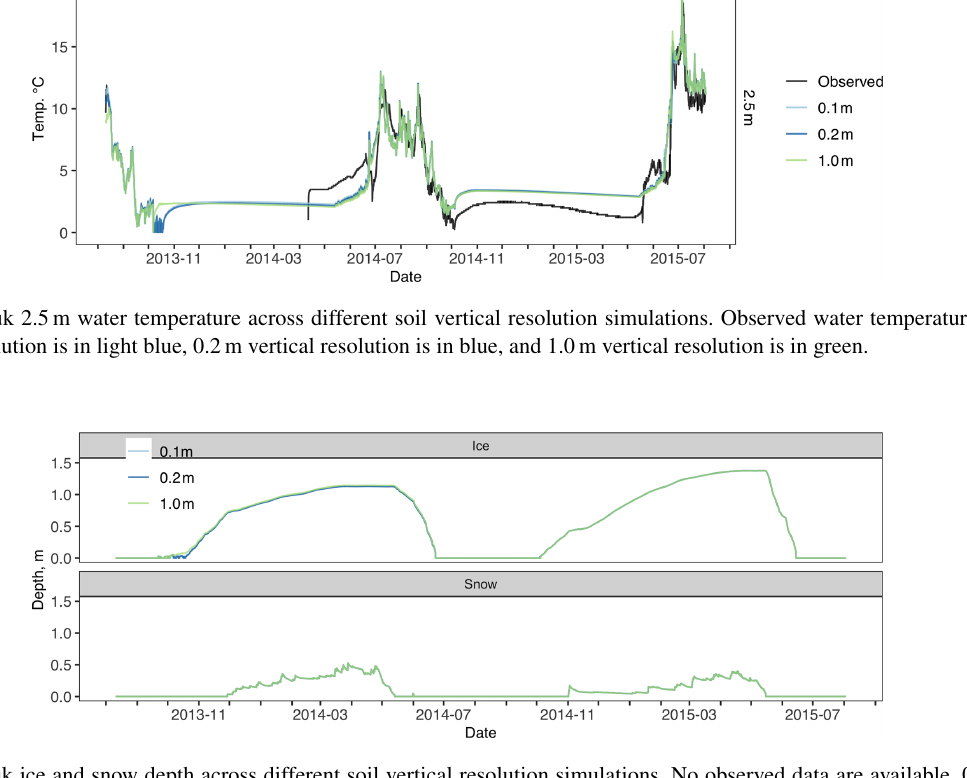
Figure E3. Atqasuk ice and snow depth across different soil vertical resolution simulations. No observed data are available, 0.1m vertical resolution is in light blue, 0.2m vertical resolution is in blue, and 1.0m vertical resolution is in green.